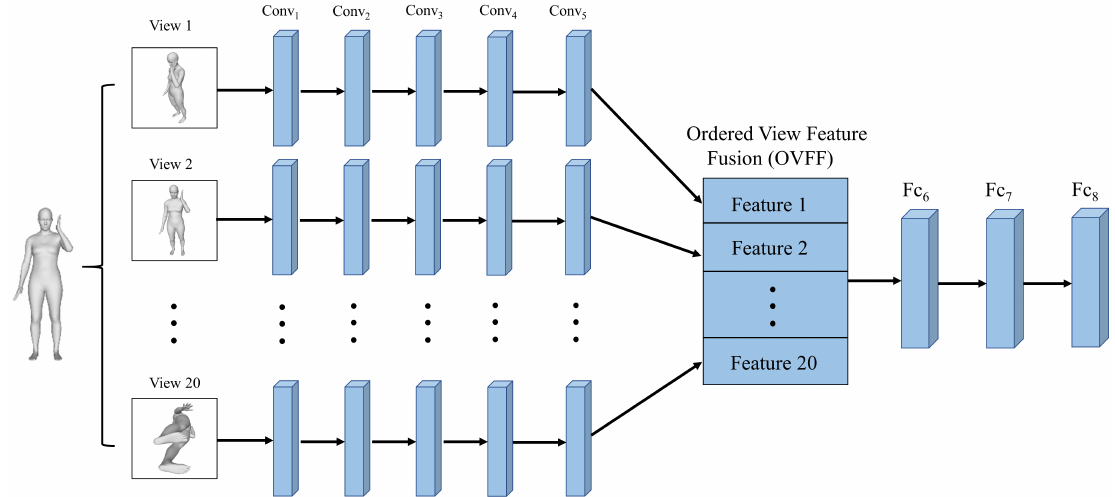
Figure 2. The process of our MVCNN for orientation-aware pose classification, where the key is the ordered view feature fusion